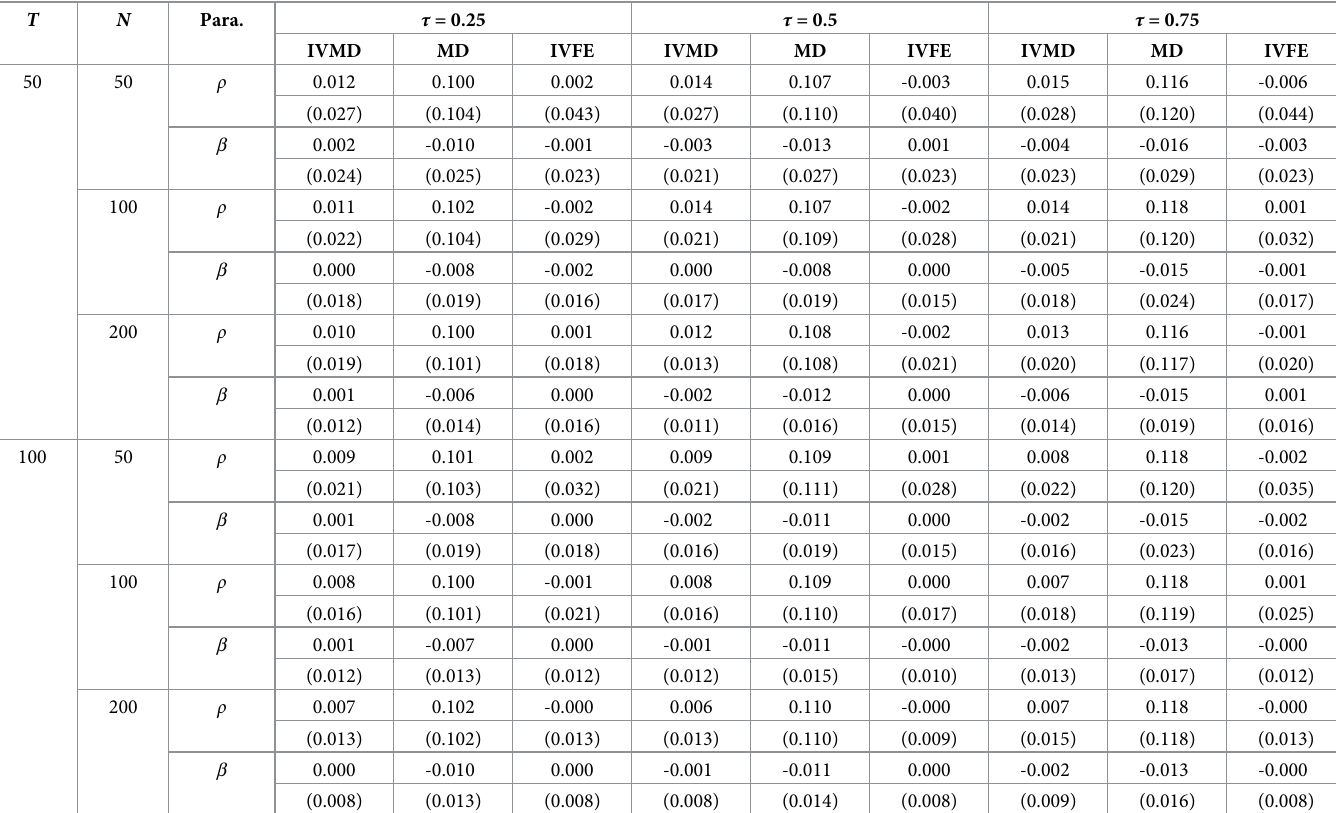
Table 2. Bias and RMSE (in parentheses) of various estimators in the heteroscedastic case. T N Para.